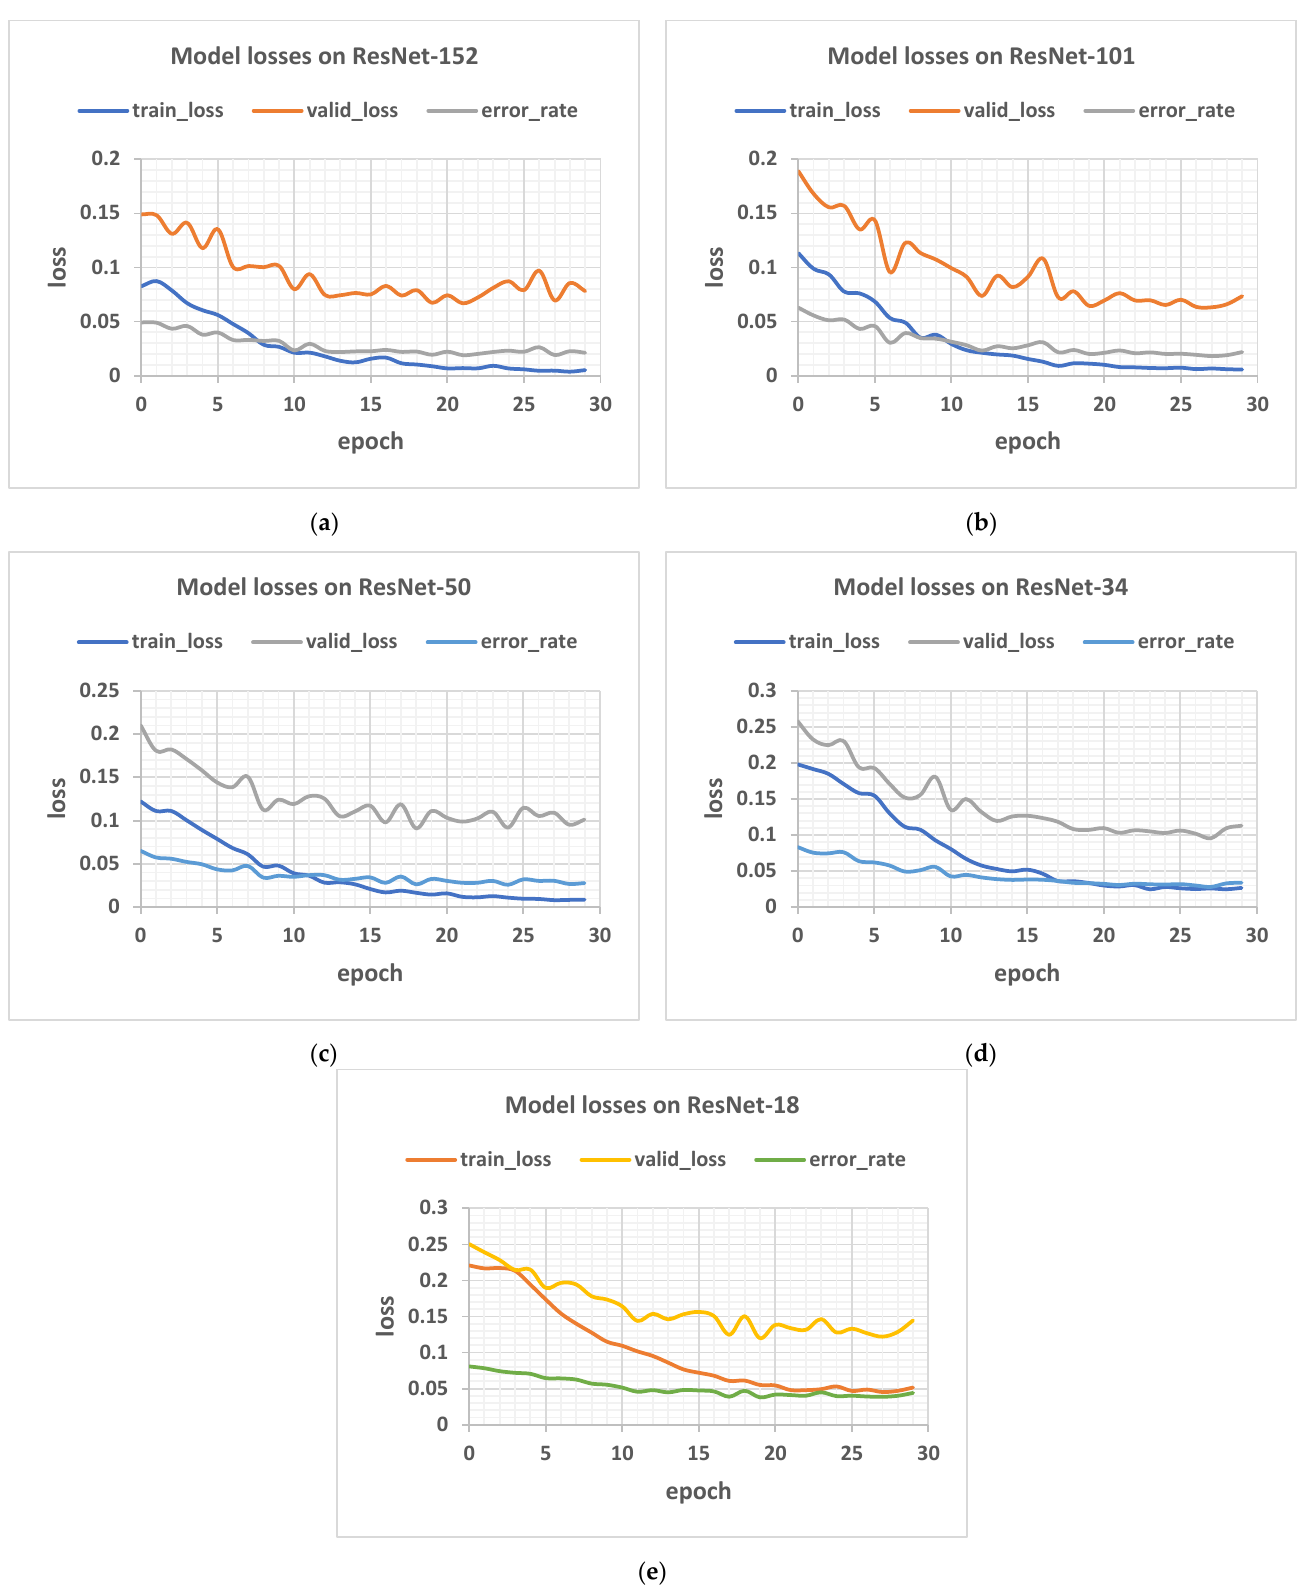
Figure 12. Showing the model losses and error rates for: ( a ) 152, ( b ) 101, ( c ) 50, ( d ) 34, and ( e ) 18 layers respectively.